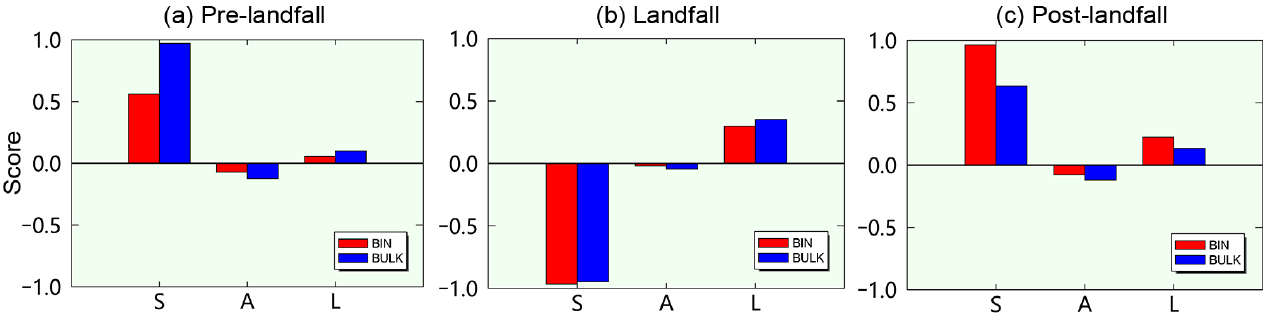
Figure 6. SAL score comparing simulated brightness temperature from BIN and BULK schemes for Typhoon In-Fa (2021) during the periods of ( a ) pre-landfall, ( b ) landfall, and ( c ) post-landfall.